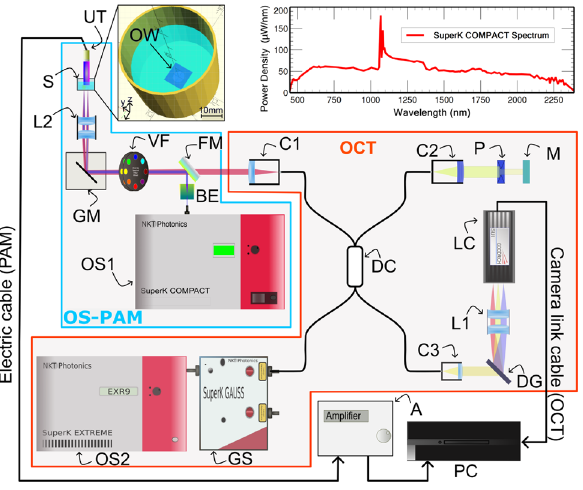
Figure 7. Schematic diagram of the OS-PAM/OCT system. OS1 OS-PAM excitation optical source (SuperK COMPACT, NKT Photonics), OS2 OCT optical source (SuperK EXTREME EXR9, NKT Photonics), GS Variable filter (SuperK GAUSS, NKT Photonics), VF Bandpass filter wheel, BE Beam expander, FM Flipping mirror, GM X–Y galvanometer mirrors, LC Line camera, DG Diffraction grating, DC 50/50 directional coupler, UT Ultrasound transducer, S Sample, C1–C3 Collimators, L1–L2 Lenses, M Flat mirror, P Pinhole, A Amplifier, OW Optical window of the 3D printed sample-holder; Drawing produced using Incscape 1.0.1 (https:// inksc ape.